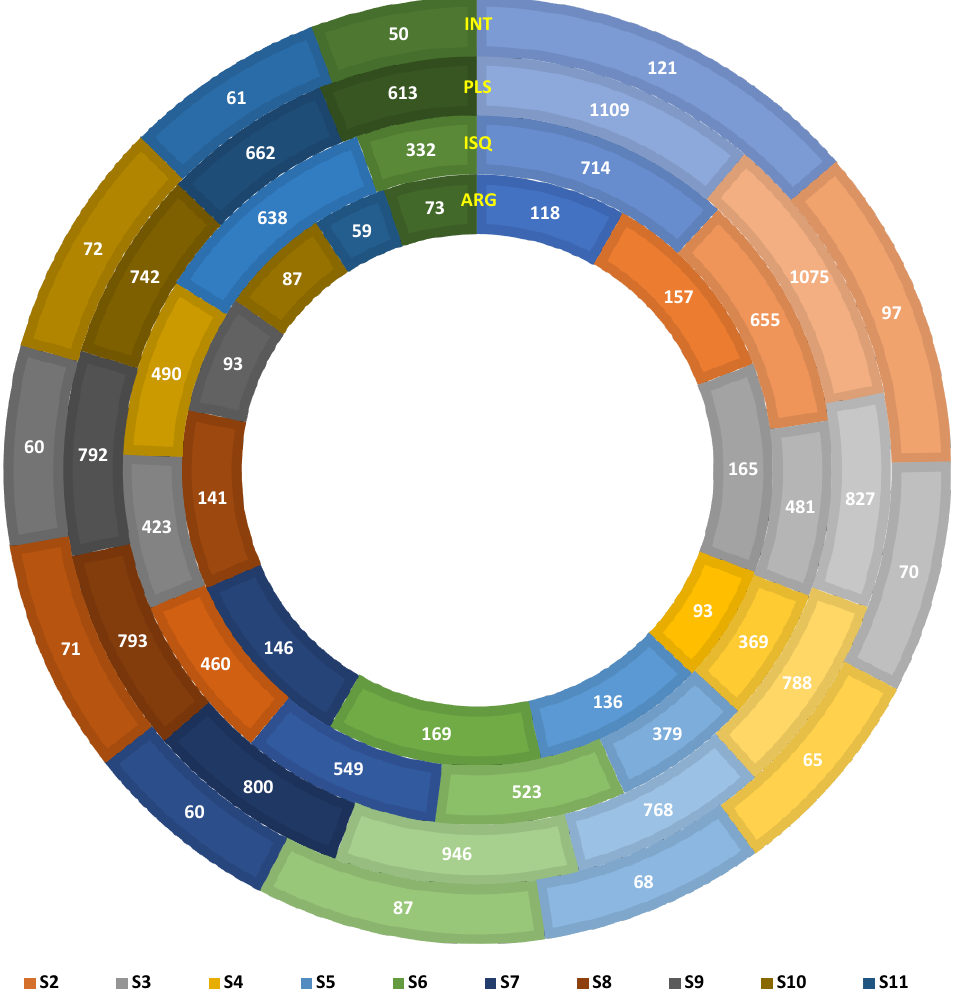
Figure 6. Antibiotic resistance gene elements detected in surface sediments of Kuwait. The circles from outermost to innermost represent the integrons (INT), plasmids (PLS), insertion sequences (ISQ), and antibiotic-resistant genes (ARGs), respectively. The sampling locations are color-coded. A color index is given at the bottom.